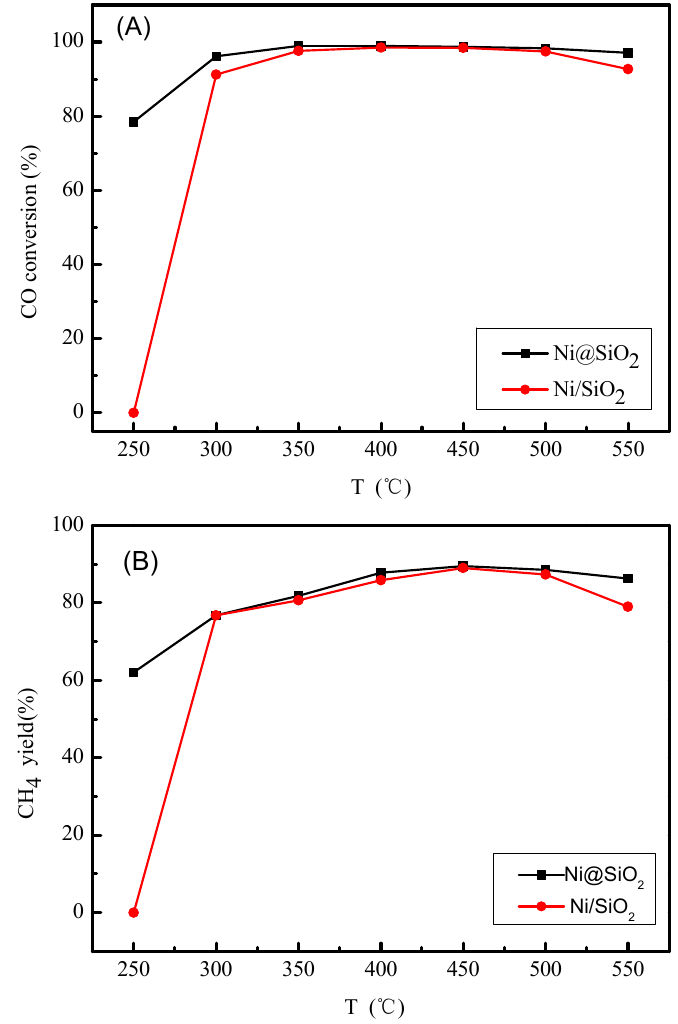
Figure 5. CO conversion ( A ) and CH 4 yield ( B ) of the Ni@SiO 2 and Ni/SiO 2 catalysts at 1.5 MPa, 36,000 mL/g/h.